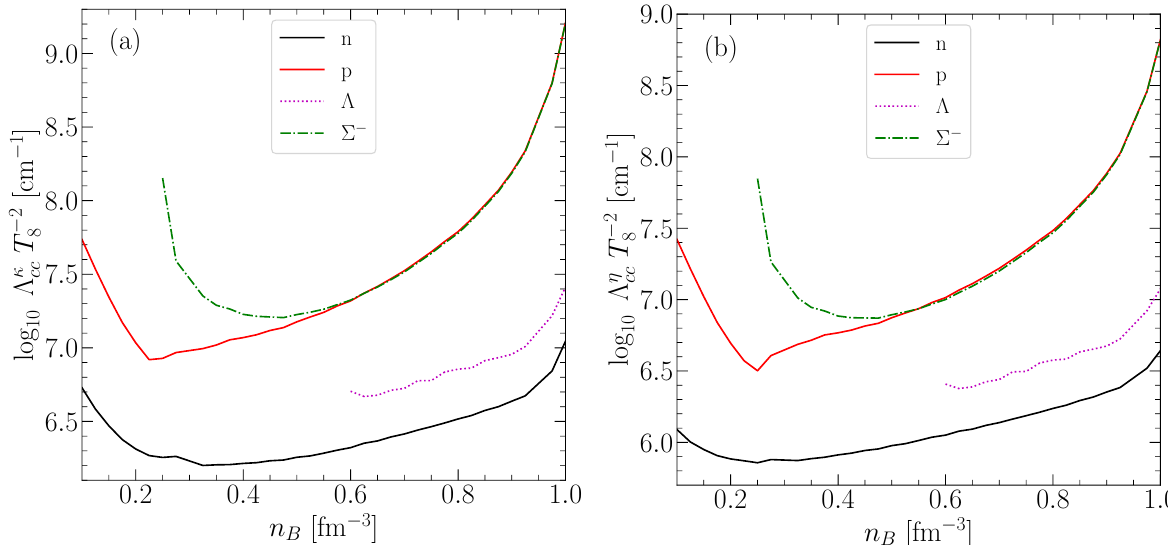
Figure 3. Diagonal elements of the transport matrix for baryons as a function of the total baryon number density. Different line types correspond to different particles, as indicated in the legend. Only the strong interaction is taken into account in this plot and temperature-independent ( Λ cc T − 2 ) combinations are shown. Results are shown for the NSC97e model, 8 respectively, for the thermal conductivity (panel ( a )) and the shear viscosity cases (panel ( b